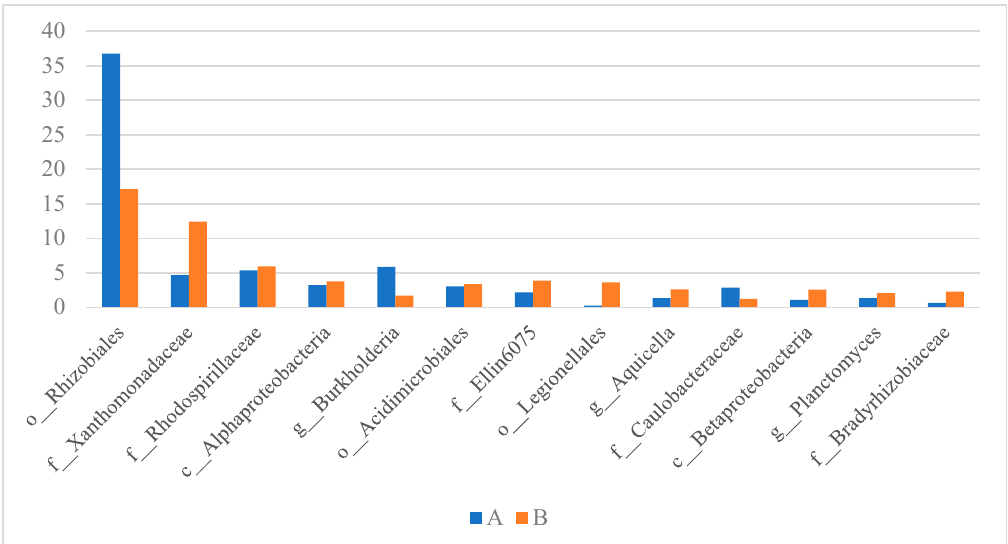
Figure 7. Detection rate of sequences at OTU level in samples A and B.